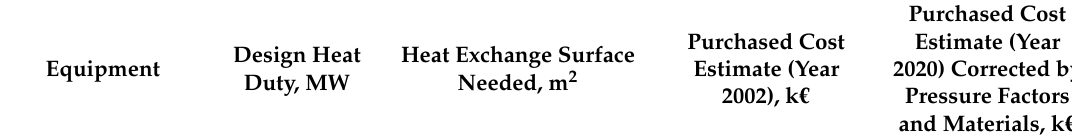
Table 9. Total investment cost estimation based on [41] for Case